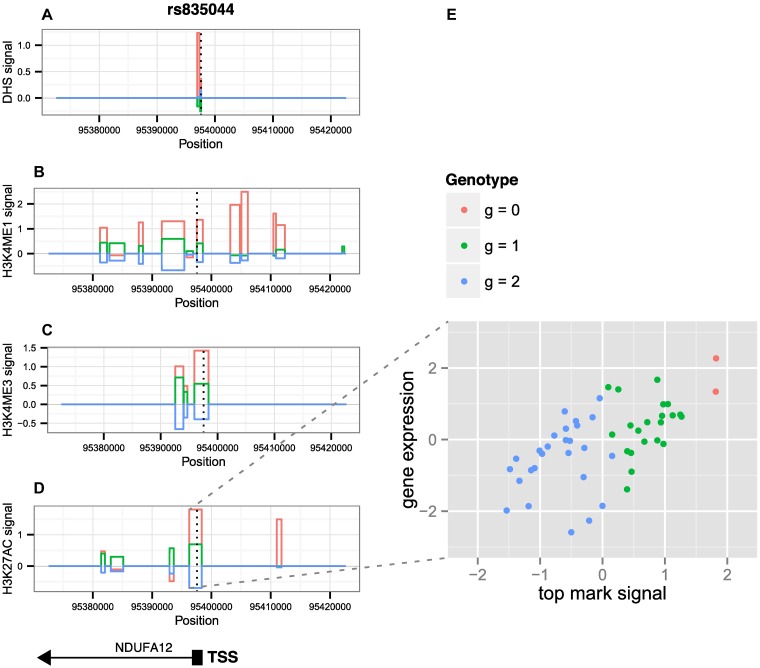
Genomic context of top path reported by pathfinder in real data.(A-D) Mark signals for DHS, H3K4me1, H3K4me3, H3K27ac in a 4kb region centered around the NDUFA12 TSS, stratified by genotype. The implicated SNP, signified by the vertical dotted line, lies 6bp downstream of the gene TSS, and falls within an H3K27ac peak, which is also the top mark reported by pathfinder. The posterior probability for causality for this peak was greater than 0.999. (E) Relationship between the H3K27ac peak signal and gene expression, stratified by genotype.